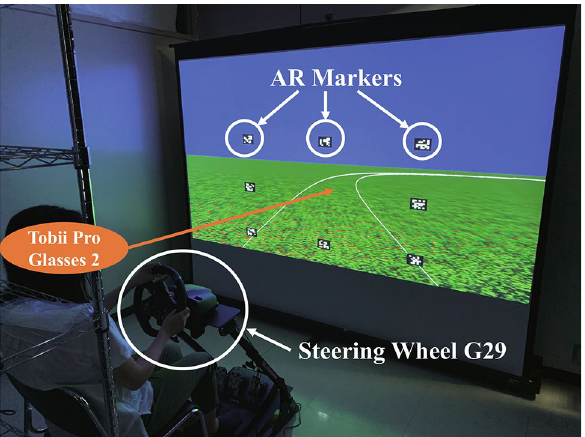
Figure 10. Driving simulator. Eight augmented reality (AR) markers were set on the screen to calculate drivers’ fixation.